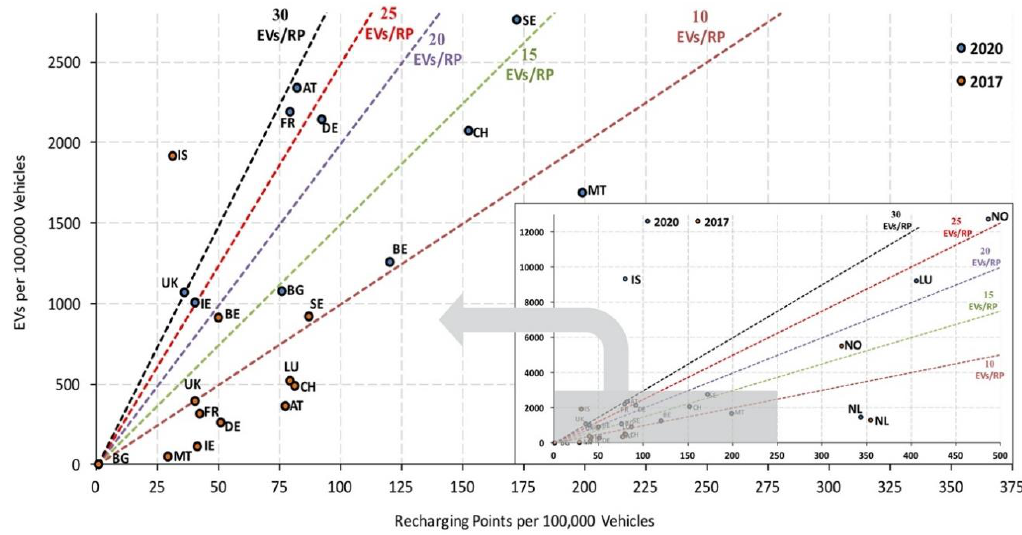
Figure 4. Current and future situation of plug-in electric vehicles (PEVs) and publicly accessible recharging points normalised by total vehicle fleet across Europe (own elaboration on data from European Alternative Fuels Observatory (EAFO) [57] and NPF [58]).